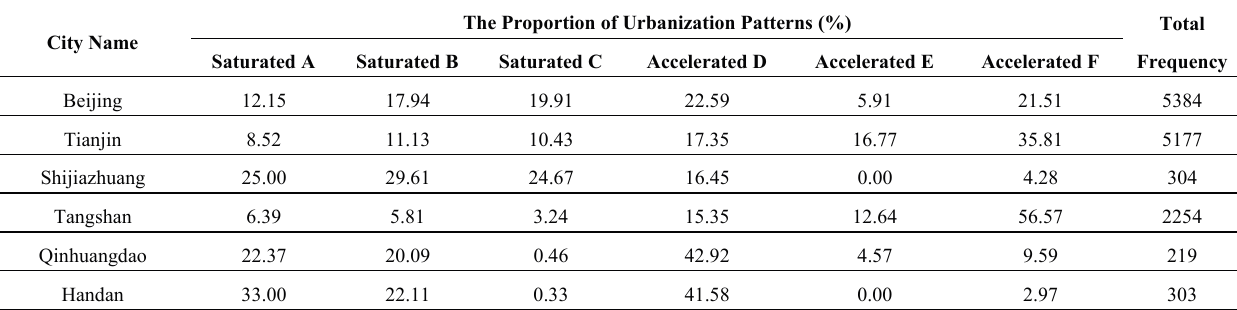
Table A1. The proportion of six patterns of NTL time series in 285 Chinese